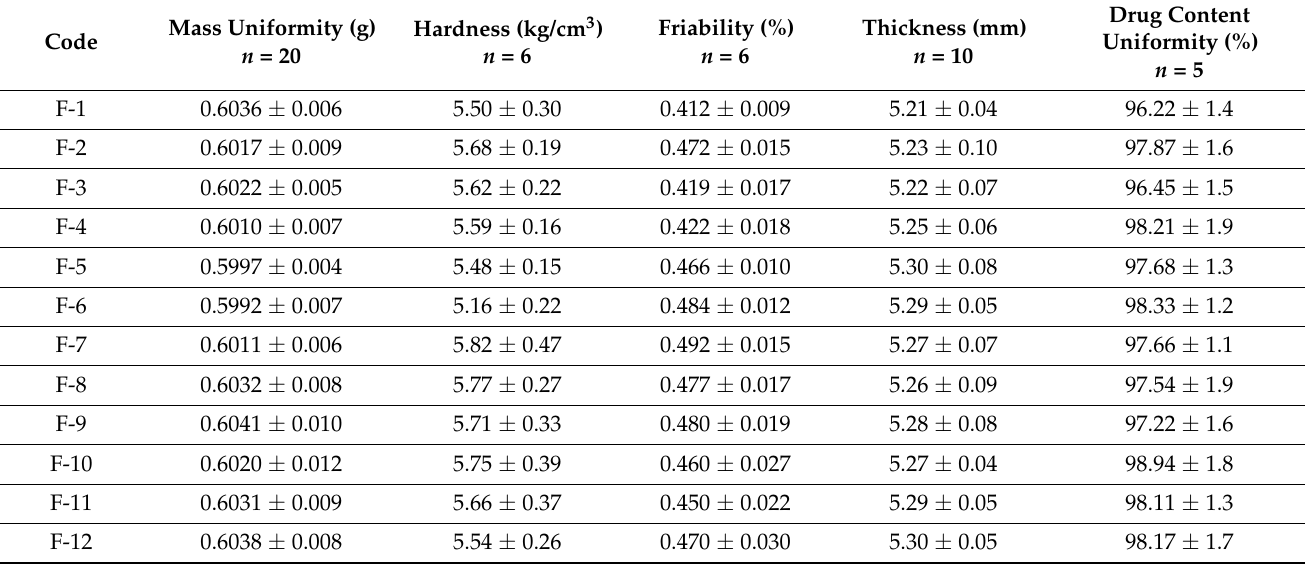
Table 2. Physical properties of modified-release tablets containing acyclovir.